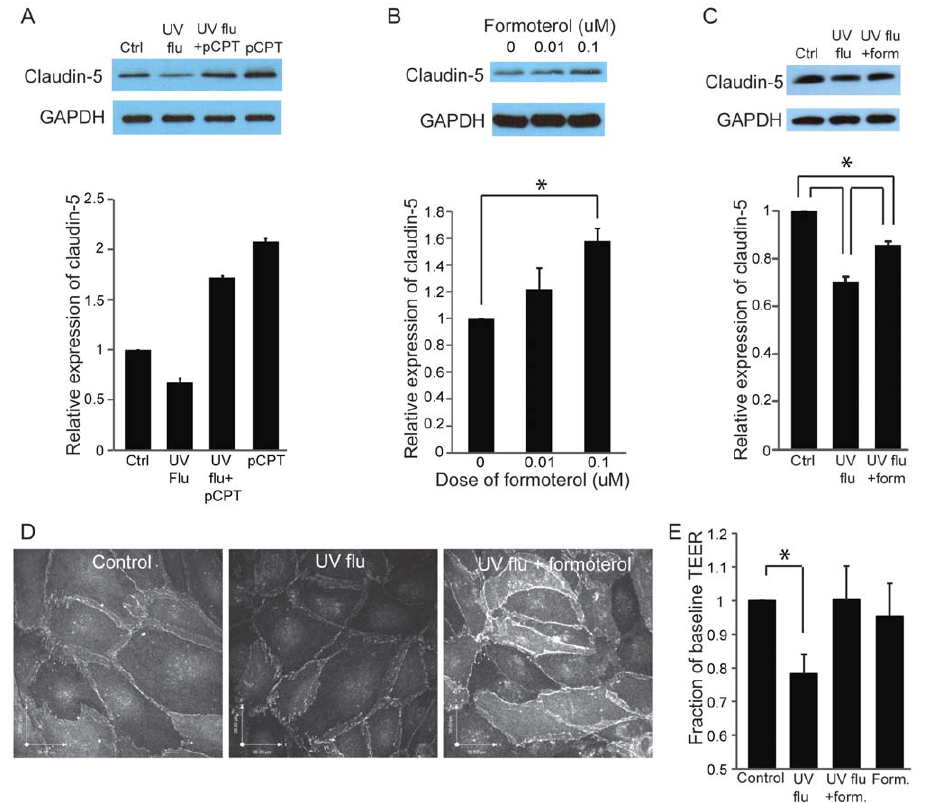
Figure 9. Formoterol induces claudin-5 protein expression and prevents virus-induced endothelial permeability. (A) Whole cell lysates were probed for claudin-5 after incubation with pCPT-cAMP (pCPT, both 24 hours before and during infection with UV-influenza, MOI 8). Blots and quantitation are representative of 5 experiments. (B) Whole cell lysates were probed for claudin-5 after 24 hours of incubation with formoterol. GAPDH is the loading control. Quantitation of claudin-5 protein levels in whole cell lysates, normalized to control (mean and SE); blot is representative of 3 experiments, *p , 0.05. (C–D) Formoterol attenuates the loss of claudin-5 induced by replication-deficient influenza. Lung endothelium was infected with replication-deficient influenza (UV-flu, MOI 8) with or without 0.1 m M formoterol. Cells were probed by Western blot for claudin-5 in C and by immunofluorescence in D. In D, note the paucity of claudin-5 at cell-cell junctions of infected cells compared to uninfected controls and the induction of the protein by formoterol. The quantitation in C (mean, SD) is normalized to control, and is representative of 3 experiments; *p , 0.05. (E) Formoterol attenuates the endothelial permeability caused by replication-deficient influenza (UV-flu). Cells were infected with UV-flu (MOI 8) with or without 0.1 m M formoterol for 24 hours and permeability was assessed by TEER. Results (mean, SE) are normalized to uninfected cells and are from 5 experiments; *p , 0.05.